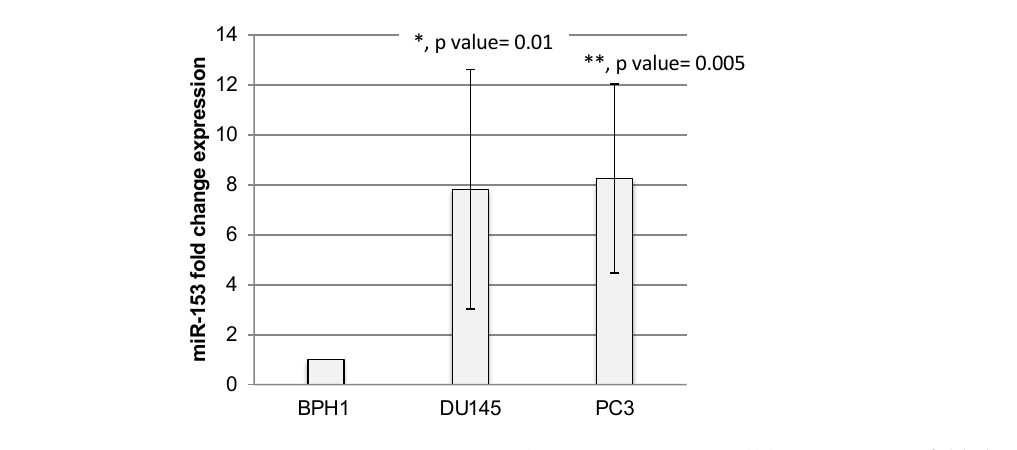
Figure 1. miR-153 is overexpressed in prostate cancer cell lines. RT-qPCR fold change expression (2 − ∆∆ Ct ± standard deviation-sd-values) of miR-153 in prostate cancer DU145 and PC3 cell lines. Summary of two experiments in triplicate ( t test, p value ≤ 0.05, *; 0.01, **).